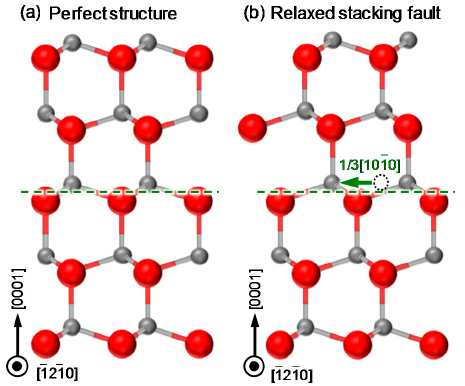
Figure 7. Schematic illustrations showing atomic structure of a stacking fault on (0001). ( a ) Perfect structure of ZnO along [1210]. ( b ) A relaxed stacking fault structure with the fault vector of 1/3[1010] after structure optimization.